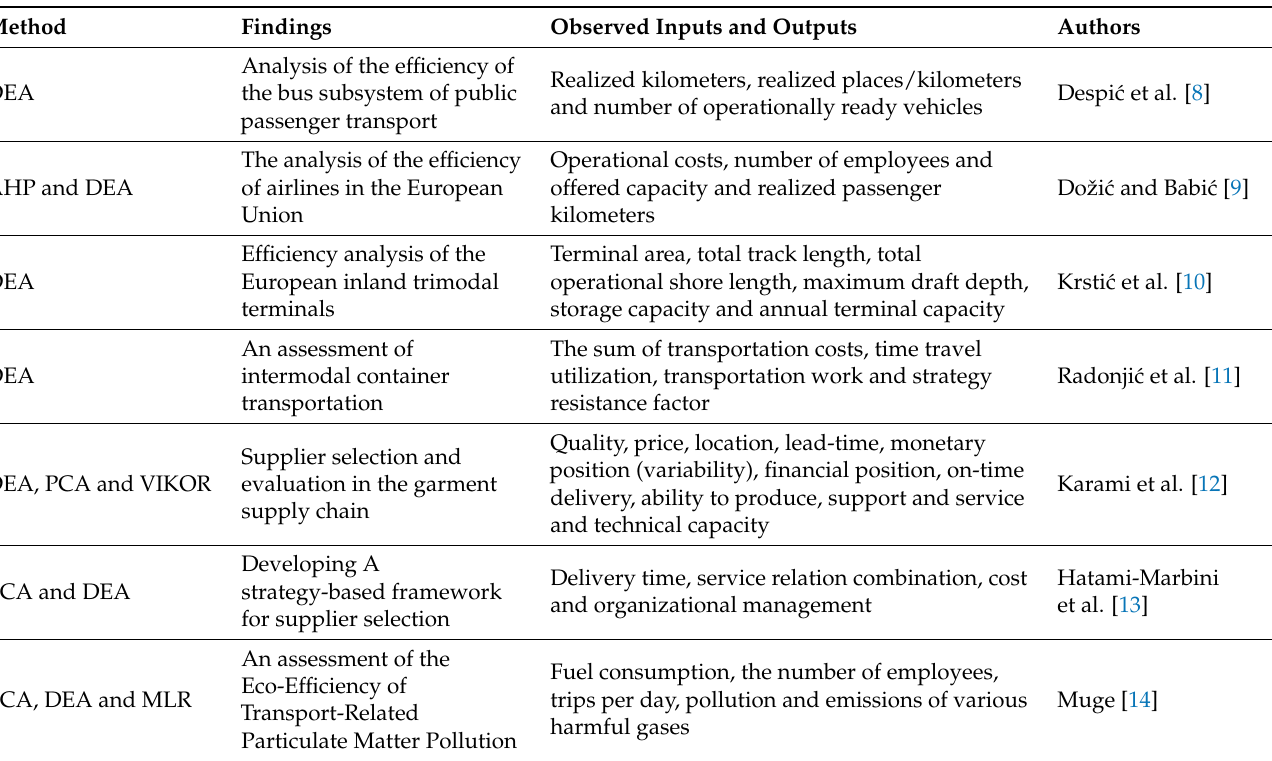
Table 1. The overview of a method for evaluating the efficiency in the field of transport and supply